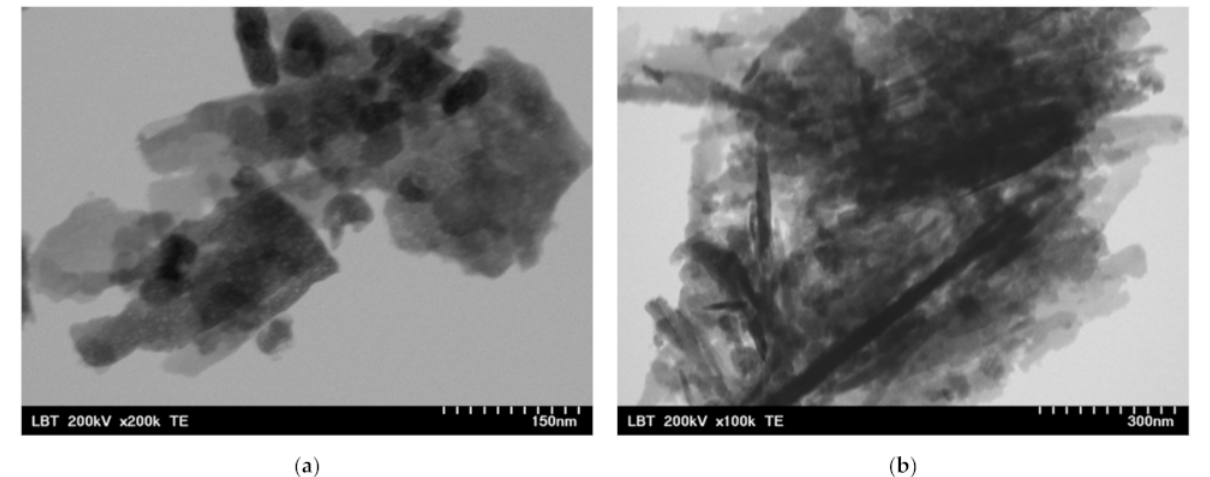
Figure 3. TEM images for ZnO:Fex nanostructures: ( a ) ZnO:Fe0 and ( b )